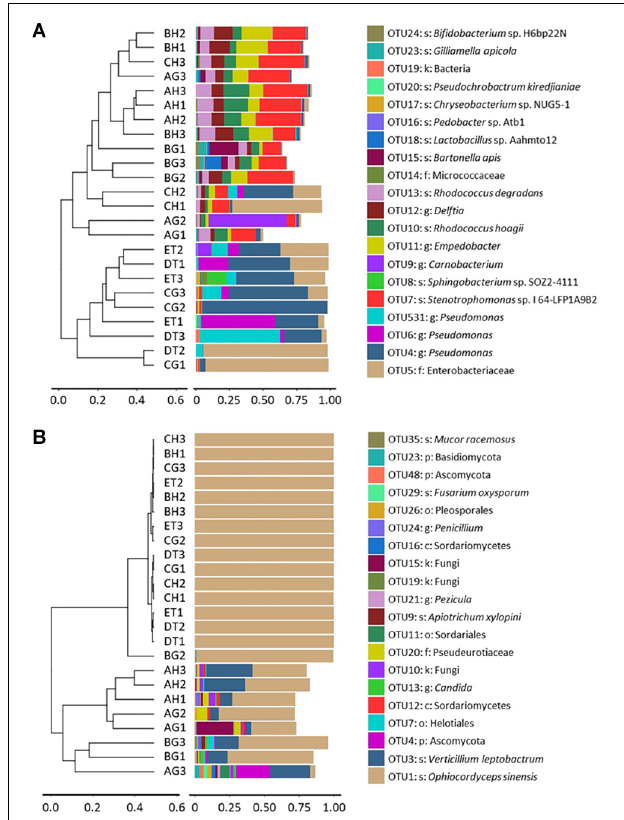
FIGURE 4 | Clustering analysis of beta-diversity based on the Bray–Curtis distance matrix for bacterial (A) and fungal (B) communities of all samples by the UPGMA method. AH and AG, hemolymph and gut of un-injected living larvae; BH and BG, hemolymph and gut of living larvae with high blastospore load; CH and CG, freshly mummifying larvae without mycelia coating; DT, tissues of the mummified larvae coated with mycelia; ET, tissues of the completely mummified larvae with